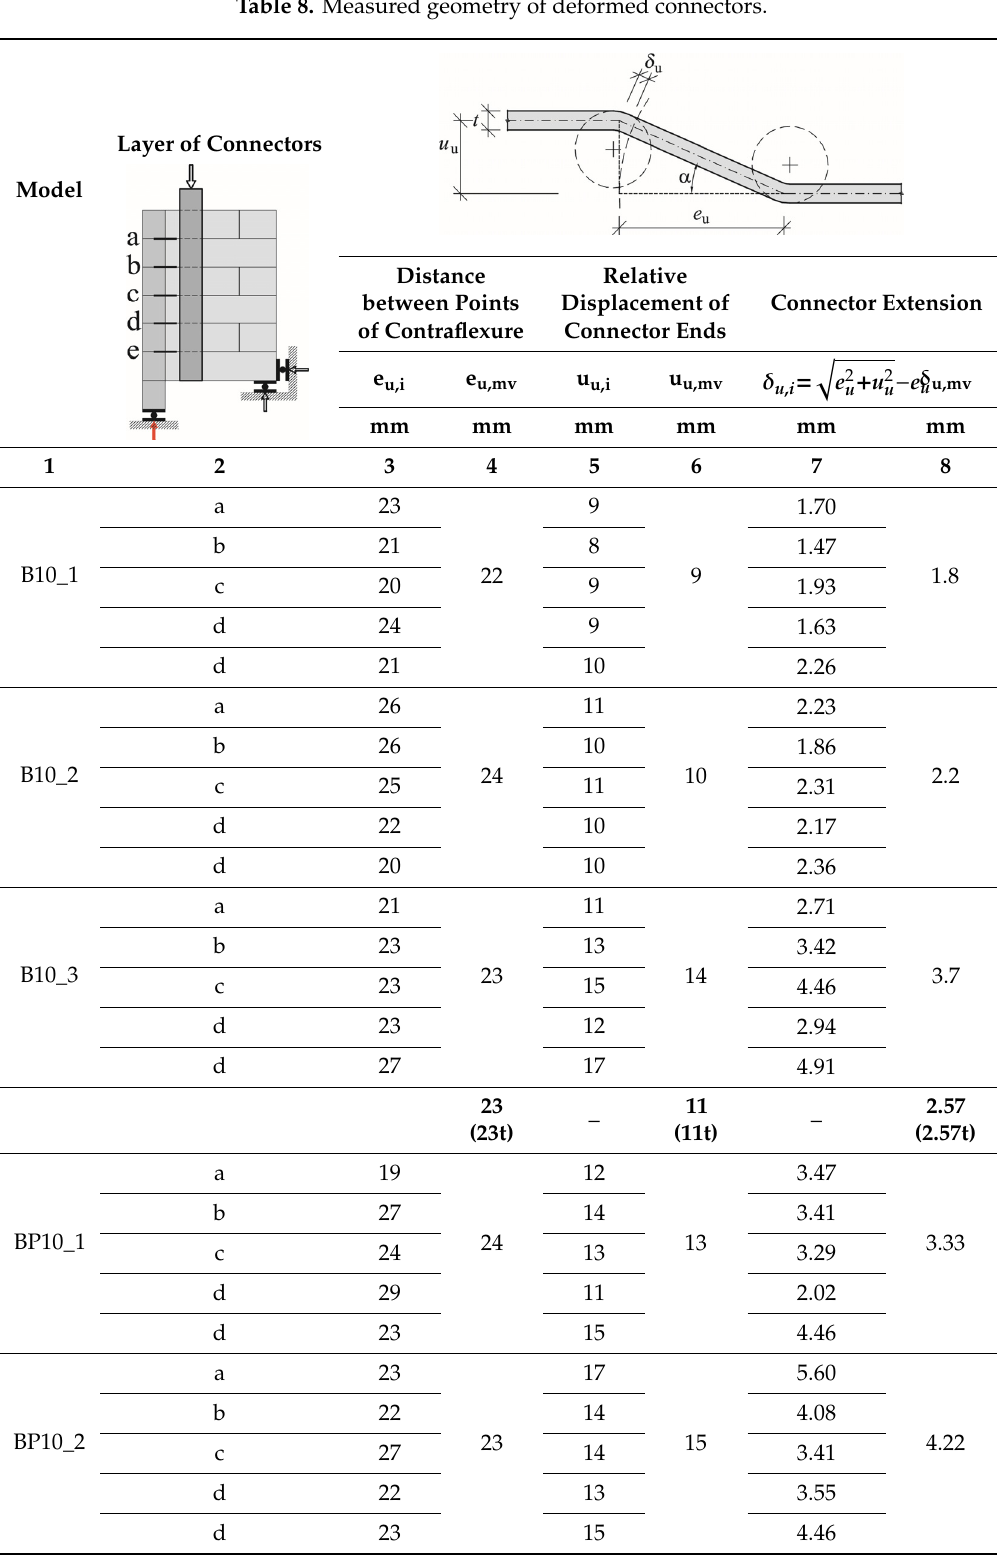
Figure 8. Deformed connectors removed from damaged test models after tests: a ) punched flat